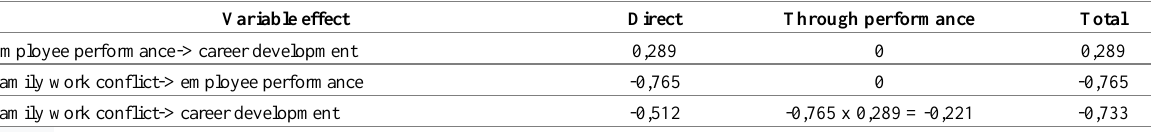
Table 4. Direct and indirect effect of research